Question: Write a caption explaining this figure to a reader.
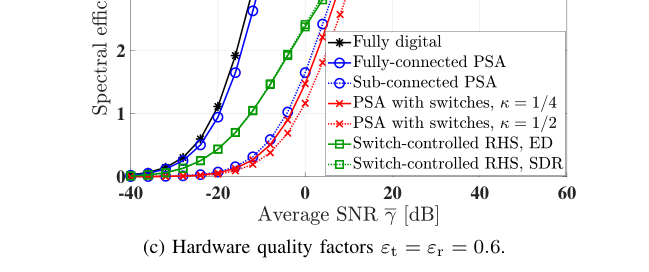
Answer: Comparison of the spectral efficiency versus the average SNR γ in various beamforming schemes.